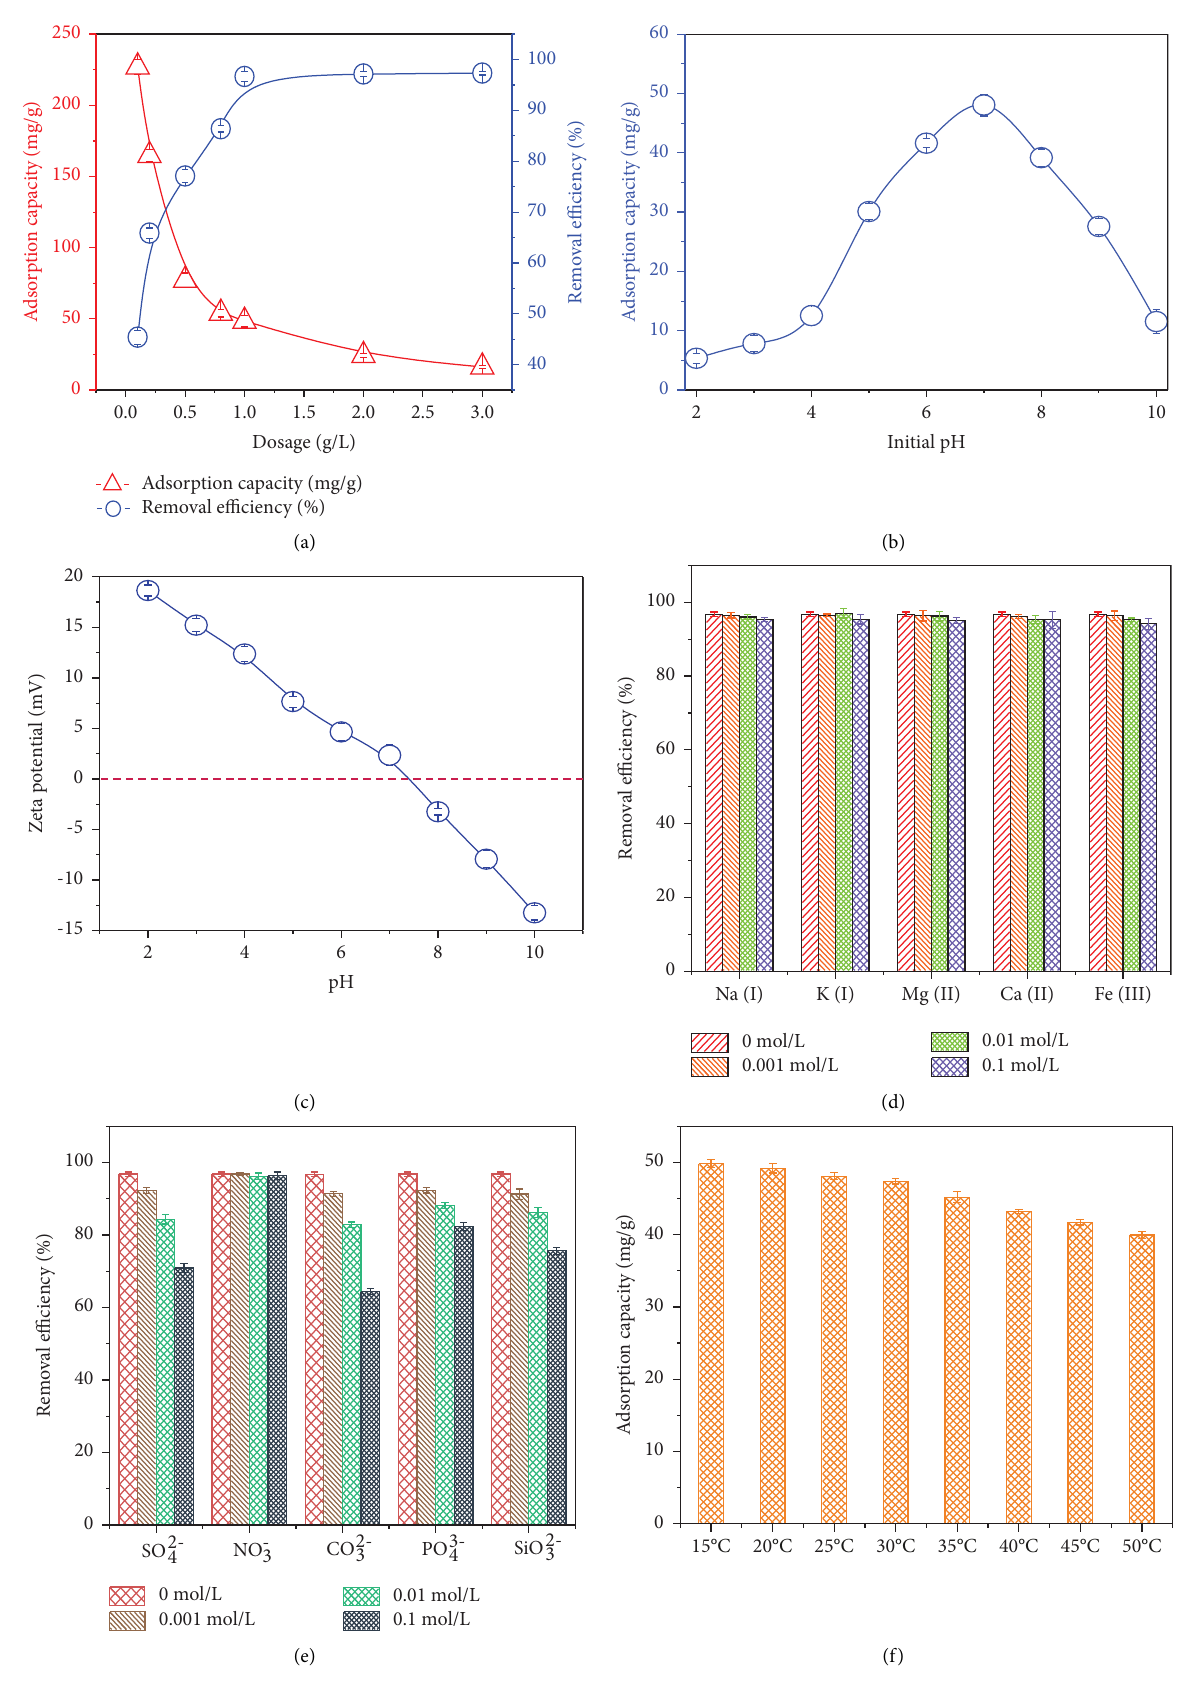
Figure 3: Te efects of dosage (a) and initial solution pH (b) on the Cl − removal by FeMn-EDTA-LDHs. Zeta potential of FeMn-EDTA- LDHs at diferent pH (c). Te efects of coexisting cations (d), coexisting anions (e), and adsorption temperature (f) on the Cl − removal by